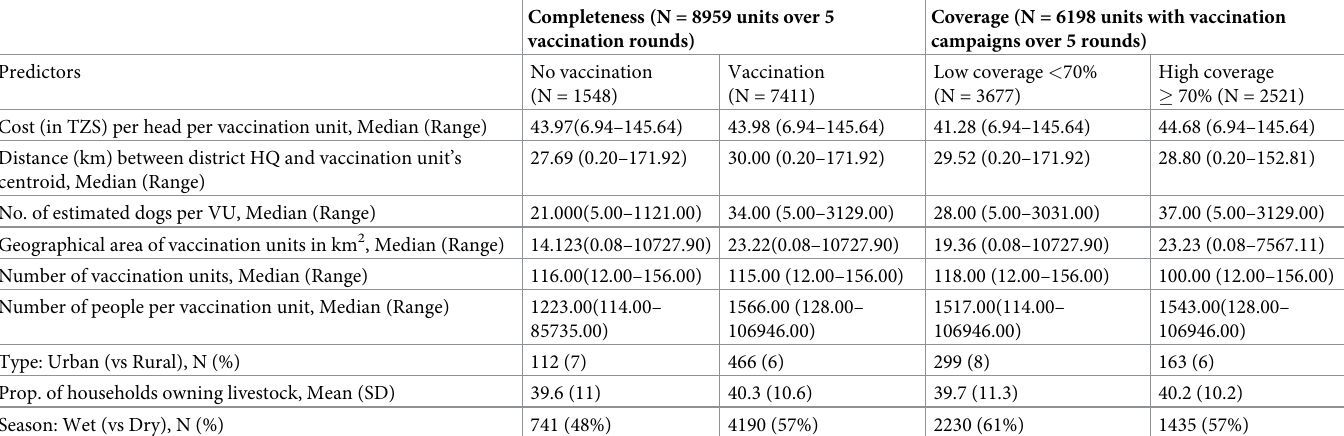
Table 2. Showing summary of data from 2,066 vaccination units over a 7-year period showing explanatory variables hypothesised to be associated with complete- ness and coverage. Statistics reported separately for vaccination units with and without completed vaccination campaigns, and with low and high coverage respectively. All these statistics were calculated at the vaccination unit-level. N = number; TZS = Tanzanian shillings; VU = vaccination unit; HQ = headquarters.